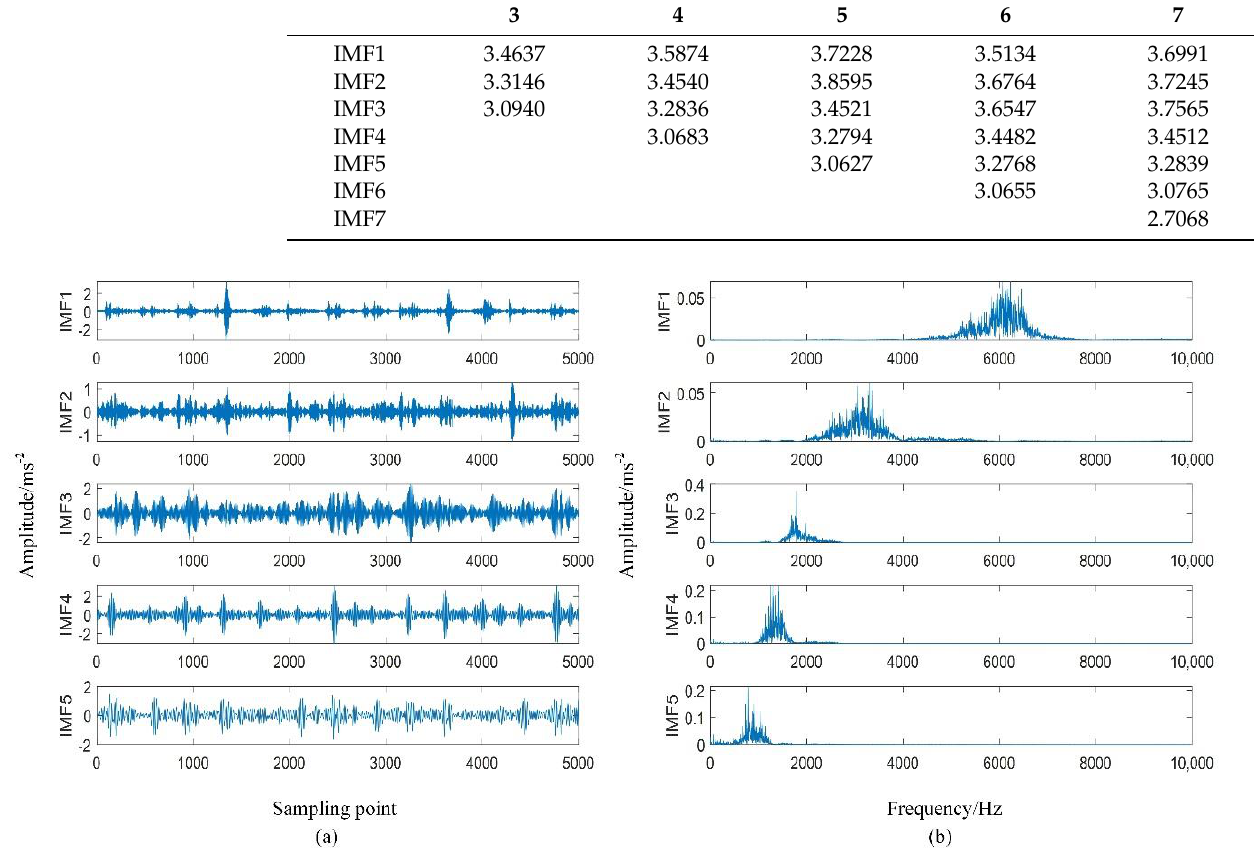
Figure 11. The VMD decompositions: ( a ) each IMF component; ( b ) each IMF component spectrogram. Figure 11b depicts that both IMF1 and IMF2 were high-frequency components with a complex spectrum and wide bandwidths. On the other hand, the IMF3, IMF4, and IMF5 components were selected as the basis for signal reconstruction when both inference signal and complex noise were taken into account. The STFT algorithm was employed to transform the denoised signal after reconstructing the two-dimensional time-frequency map data conducted by the VMD. The sampling length of each fault was uniformly set to 5000, and the size of the time-frequency map was uniformly assigned to 227 × 227